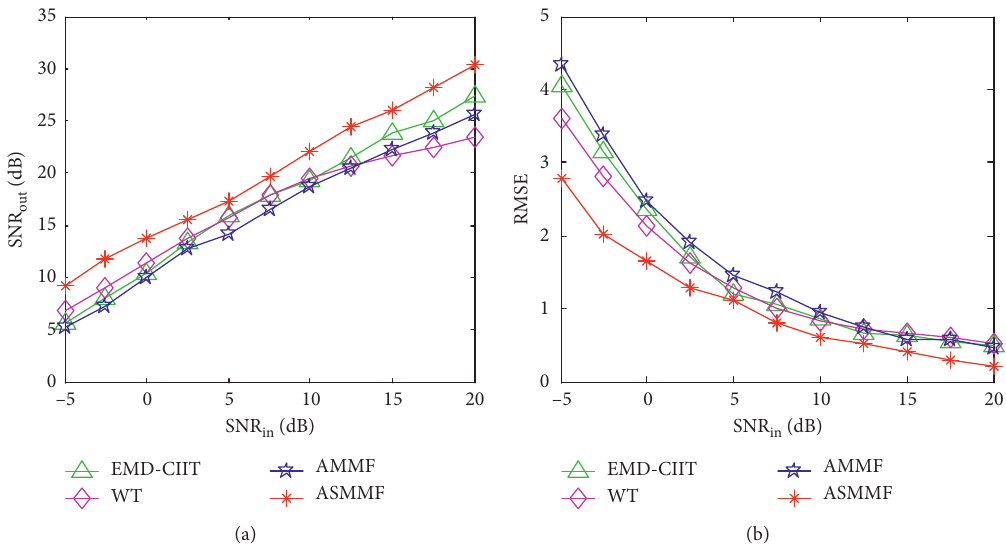
Figure 8: Analysis of signal denoised by different algorithms: (a) SNR